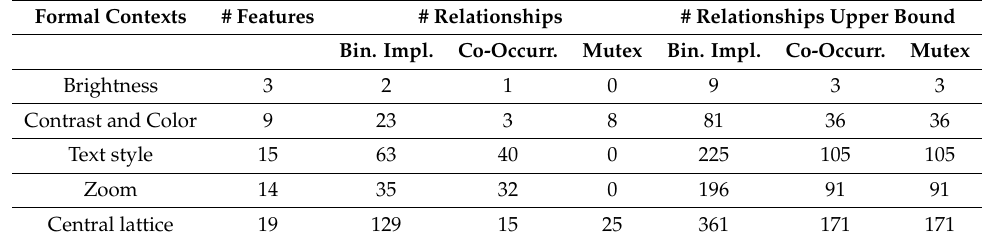
Table 6. Metrics on binary implications, co-occurrences and mutex for the fictitious systems.